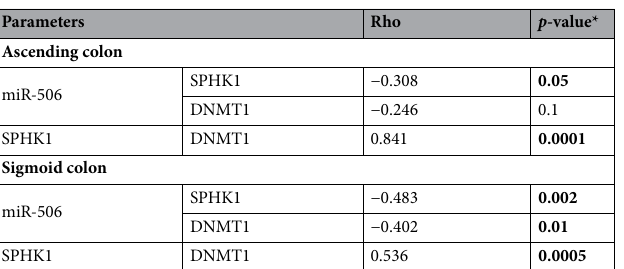
vs. controls), AE2 (4.3-fold, p = 0.01 vs. controls), and InsP3R3 mRNA (3.4-fold, p = 0.0009 vs. controls, Fig. 4b). Moreover, a pro-inflammatory response was induced in Caco-2 cells by treatment with lipopolysaccharide (LPS).